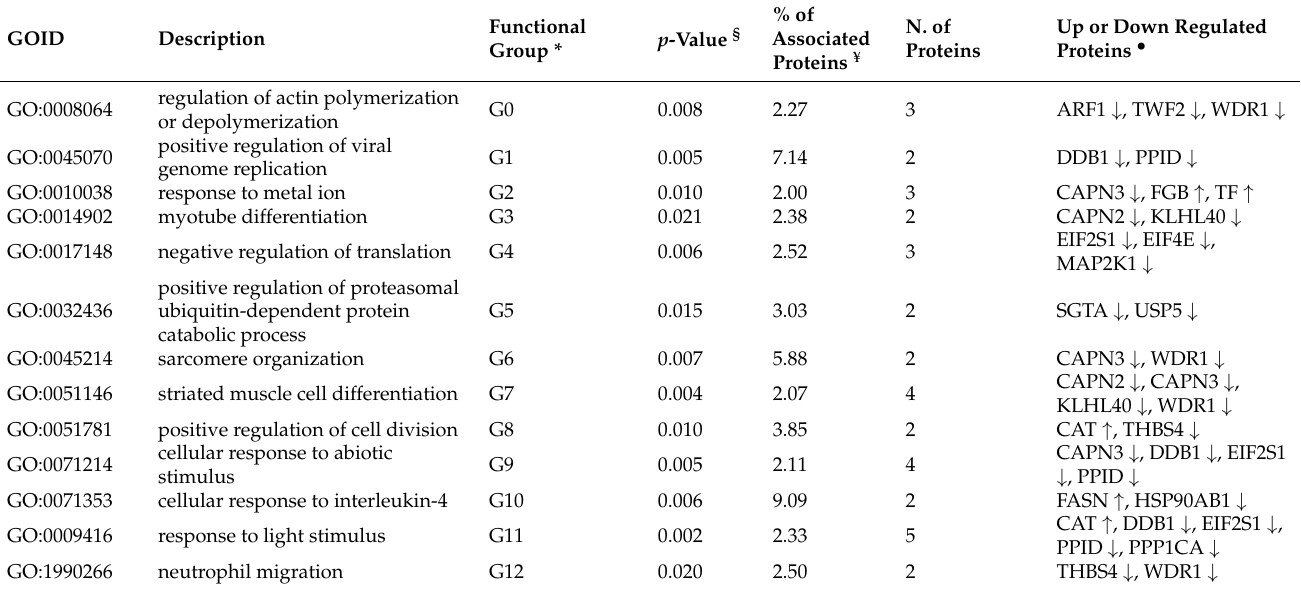
Table 2. Gene ontology biological process analysis (GO:BP) of differential proteins in the goat breed